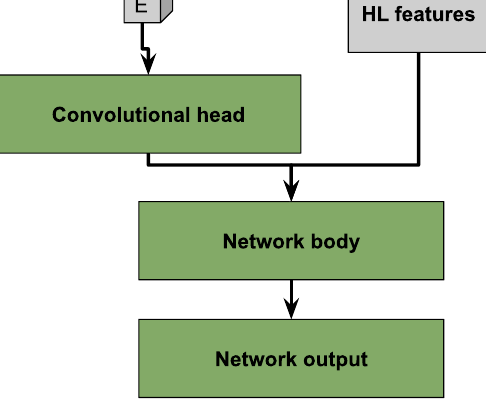
Fig. 3 Diagrams illustrating the three types of models used